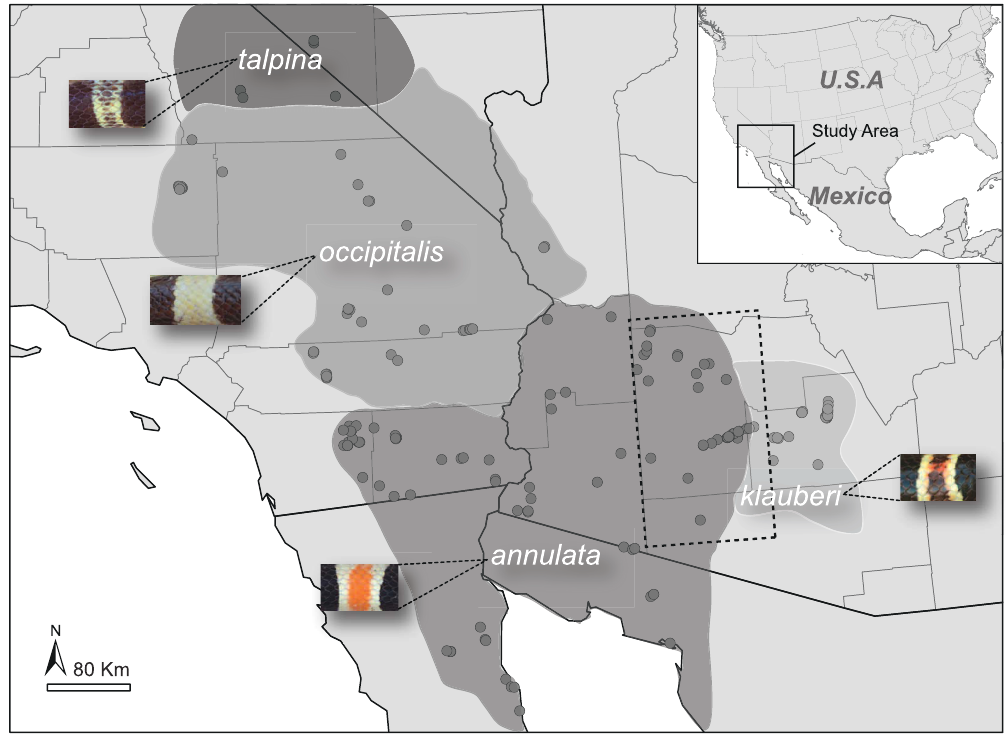
Figure 1. Subspecies distribution and dorsal color patterns of the western shovel-nosed snake ( Chionactisoccipitalis ) along with genetic sampling locations (black dots). The presumed range of the morphological intergrade zone at the interface of C. o. annulata and C. o. klauberi is depicted by the dashed line.